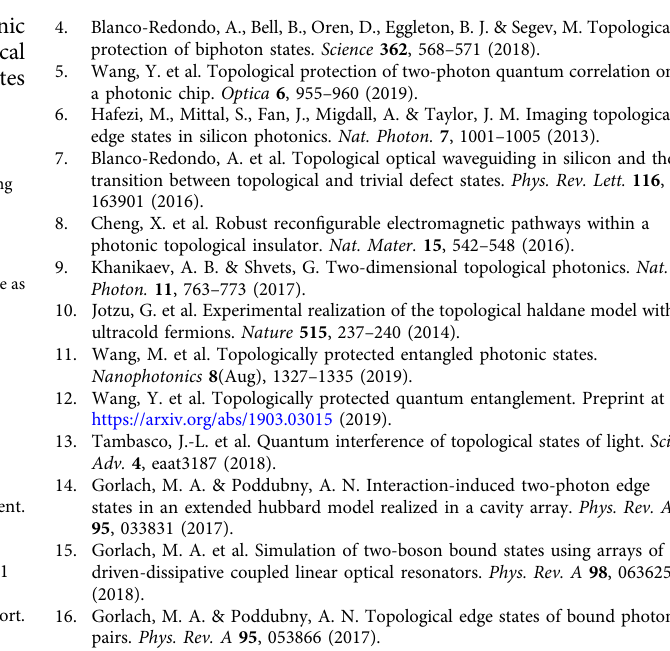
Fig. 4 Topological window of protection. In order to identify the topological window of protection, we considered a spectrally broad product state with ( σ a = σ c = 0.01) as initial state and propagate it through an ensemble of 1000 random Haldane lattices. In a we depict the spectral correlation map for the initial state. b depicts the ensemble-average of the spectral correlation maps inside the edge – edge subspace after the propagation through the ensemble of disordered lattices. We fi nd that the only two-photon amplitudes that survive the disorder lie in the region indicated by the black square, which is the protection window. c shows the edge – mode content E and d the product of the edge – mode content and the Schmidt-number E ⋅ S N as a function of the parameters σ a , σ c of the initial states in the range σ a , σ c ∈ [0.01,